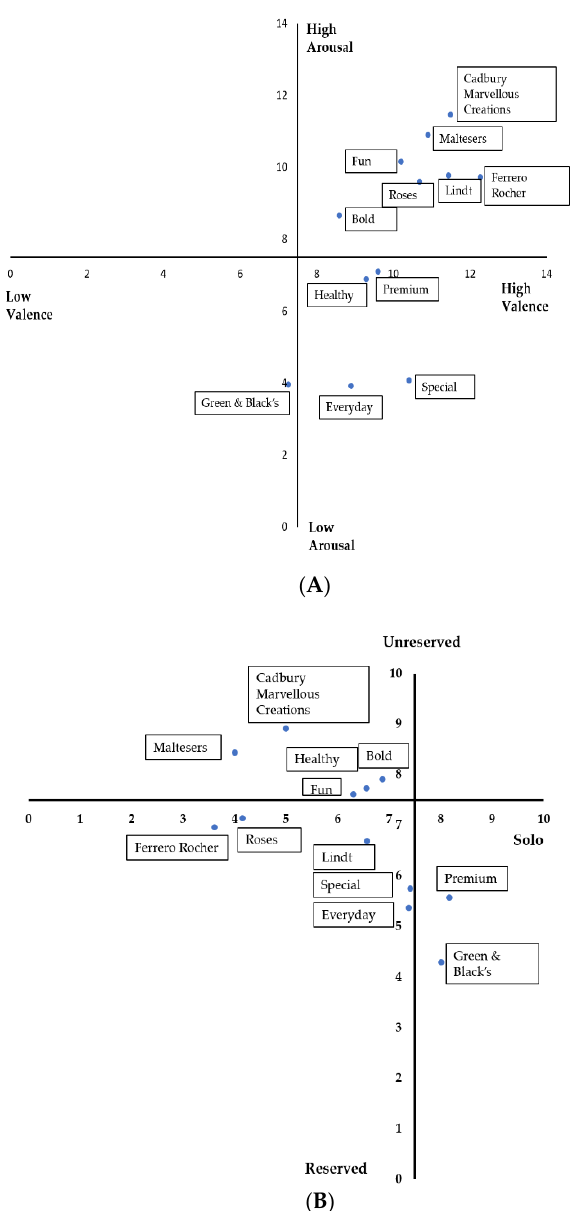
Figure 2. Perceptual map of ( A ) valence vs. arousal ( B ) reserved / unreserved vs. group / solo scores obtained by the packaging concepts showing the positioning of familiar and novel (nonfamiliar) brands.